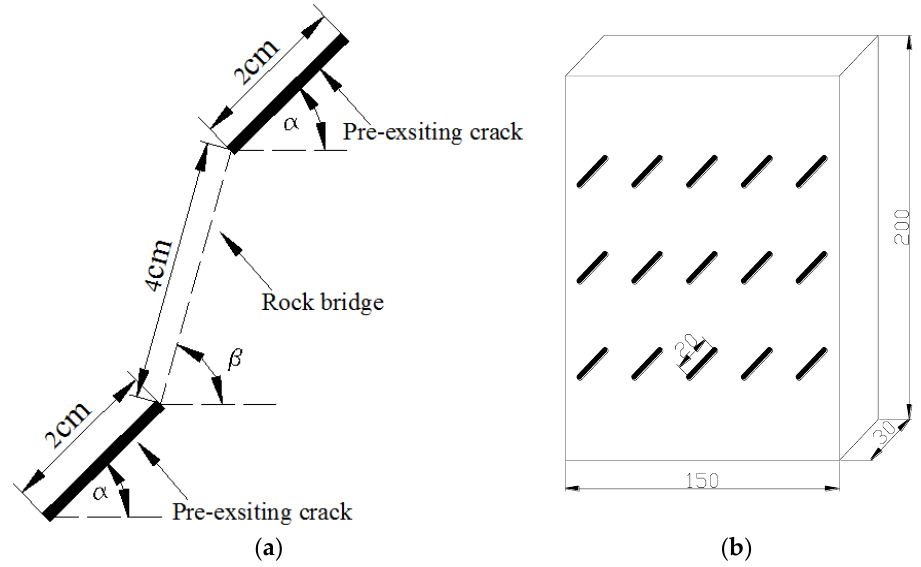
Figure 1. Multiple-cracked rock-like material used in the present study. ( a ) Two cracks; ( b ) Multiple cracks.